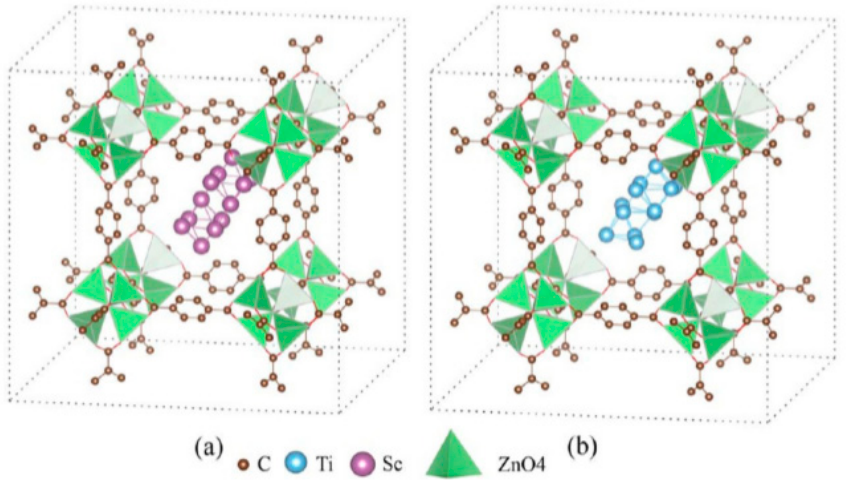
Figure 11. Optimized geometry of MOF-5 in which a cluster of 12 metal atoms of Sc ( a ) or Ti ( b ) is relaxed inside the pore. Reprinted with permission from [179]. Copyright © 2012, American Chemical Society. All rights reserved.